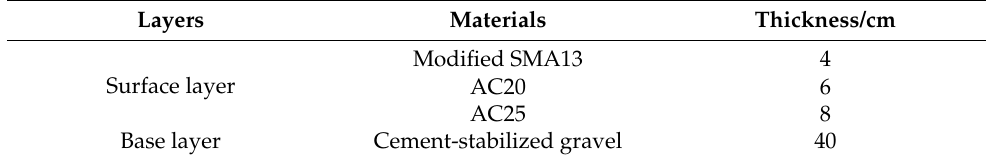
Table 1. Pavement structure information.